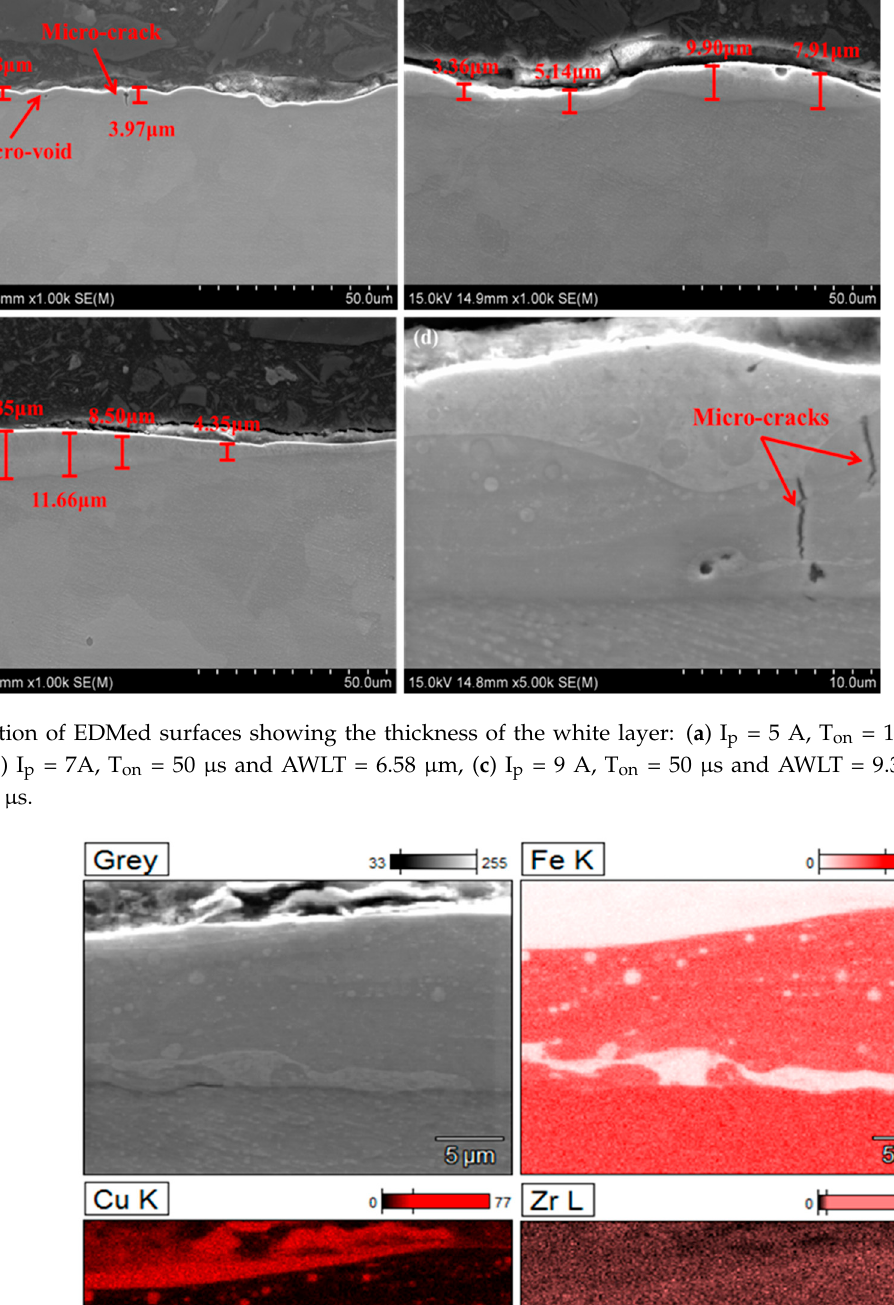
9 of 16 Figure 5. EDS mapping of the machined surface for Ip = 5 A and Ton = 12.8 μ s. The cross-section of EDMed surfaces under varying conditions was investigated by SEM analysis, as shown in Figure 6. A non-uniform recast layer was formed on the surface by the re-solidification of the unexpelled molten metal. This inhomogeneity of the recast layer can be justified by the random scattering of electrical discharges on the surface. From Figure 6a–c, it can be seen that the thickness of the white layer depends on the discharge energy. The white layer thickness (WLT) increases as the pulse current and pulse-on time increase. This is attributed to the fact that as the discharge energy increases, more heat is placed on the electrodes, and consequently, more volume of the molten material is pro- duced. The amount of molten material cannot be effectively flushed away by the dielectric fluid and re-solidified on the machined surface to form the WL. Therefore, the thickness of the WL depends on the amount of molten material produced during the process due to high discharge energy [9,20,28]. In particular, the average white layer thickness (AWLT)